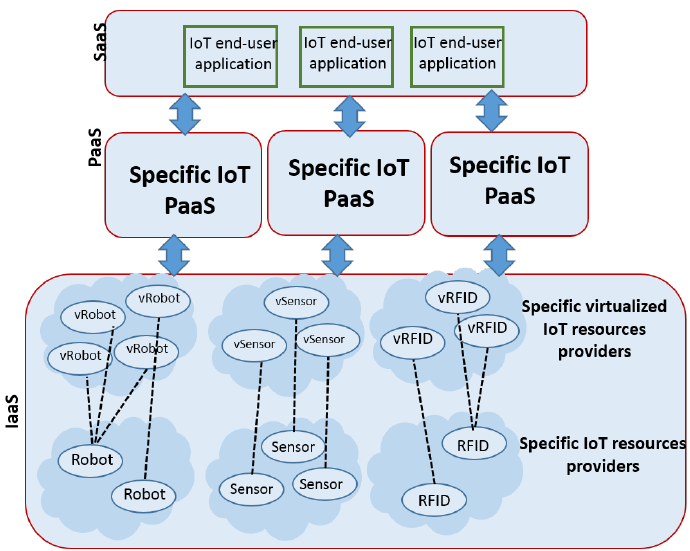
Figure 3. Specific IoT PaaS for specific IoT